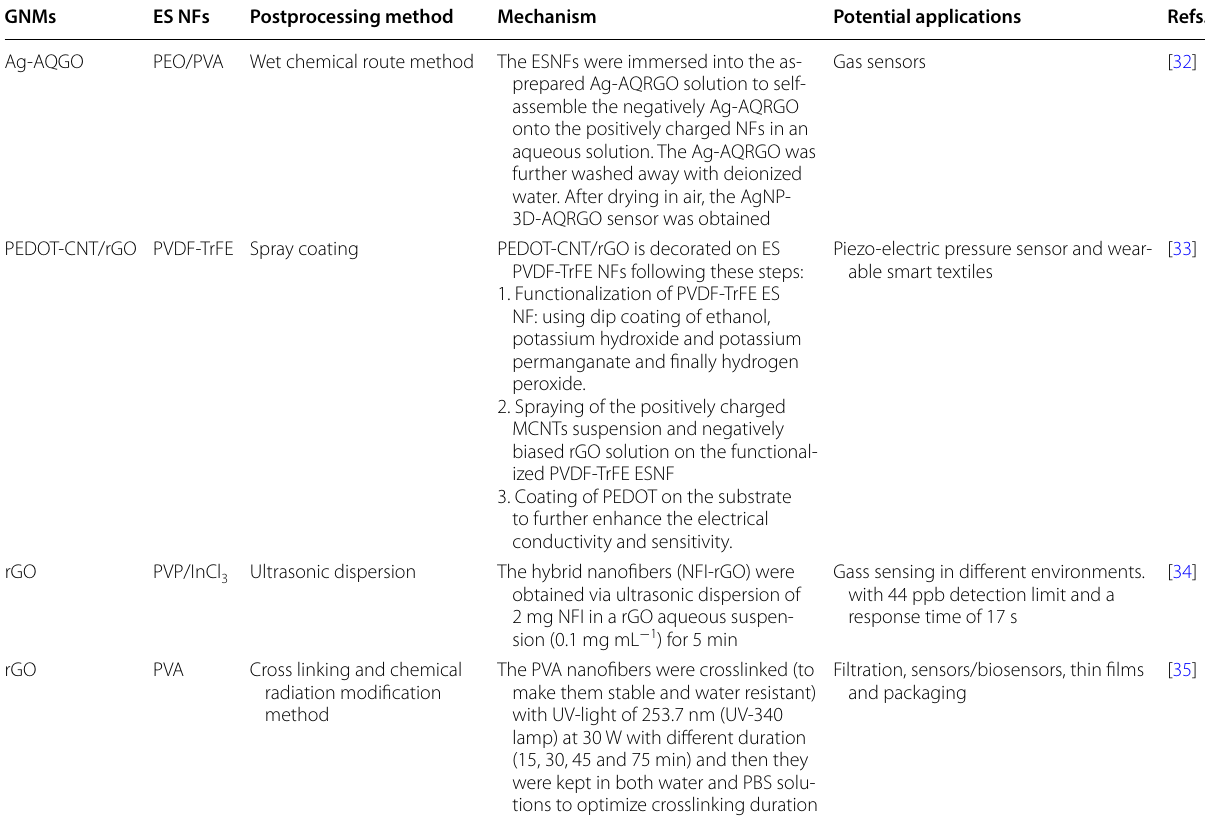
Table 2 Summary of recent significant works on electrospinning design of GNMs with polymer matrices using post‑ processing